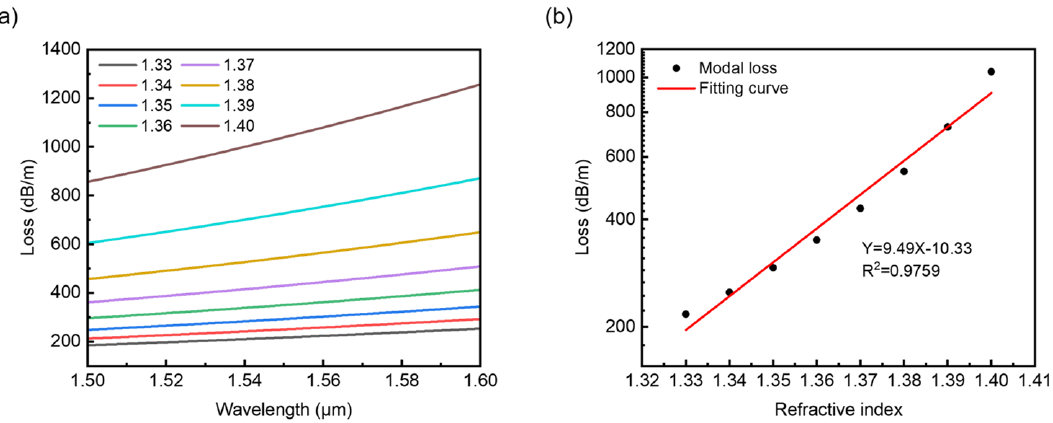
Figure 6. ( a ) Wavelength-dependent loss spectra with analyte refractive index changing from 1.33 to 1.40. ( b ) Linear fitting of loss increasing with refractive index n a for wavelength 1.55 μ m. For twist rate A = 12.1 cm − 1 where significant couplings occur with n a = 1.33 cor- responding to the blue curve in Figure 4e, the wavelength-dependent loss spectra near wavelength 1.55 µ m are also calculated, as shown in Figure 7. In the vicinity of the resonant coupling conditions, we can see a series of loss peaks appeared in the loss spectra for different n a . Initially, one can see that the loss peaks increase and shift towards longer wavelengths with rising n a . However, for a relatively high refractive index n a , such as n a = 1.40, the overall loss is higher than the resonant peaks corresponding to n a = 1.33 and 1.34 in the wavelength range shown in Figure 7. This indicates that for increments of the refractive index n a taking 0.01, the increase in and movement of the loss peaks are mainly nonlinear and irregular in this case. Hence, we calculate the loss spectra with n a changing from 1.33 to1.34 by taking 0.001 as an increment in the refractive index this